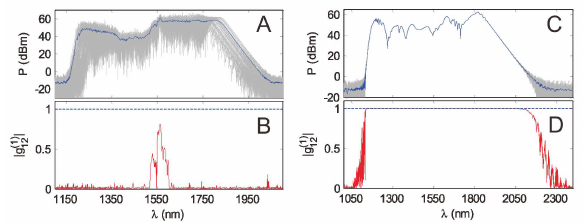
Figure 12: (A) and (C) are SC spectra (gray curves are the SCs of individual shots and blue curves are the shot average). (B) and (D) are the corresponding moduli of the complex degree of first- order coherence of the SC. The left column is for the picosecond pump pulse and right column is for the femtosecond pump pulse. (Adapted from